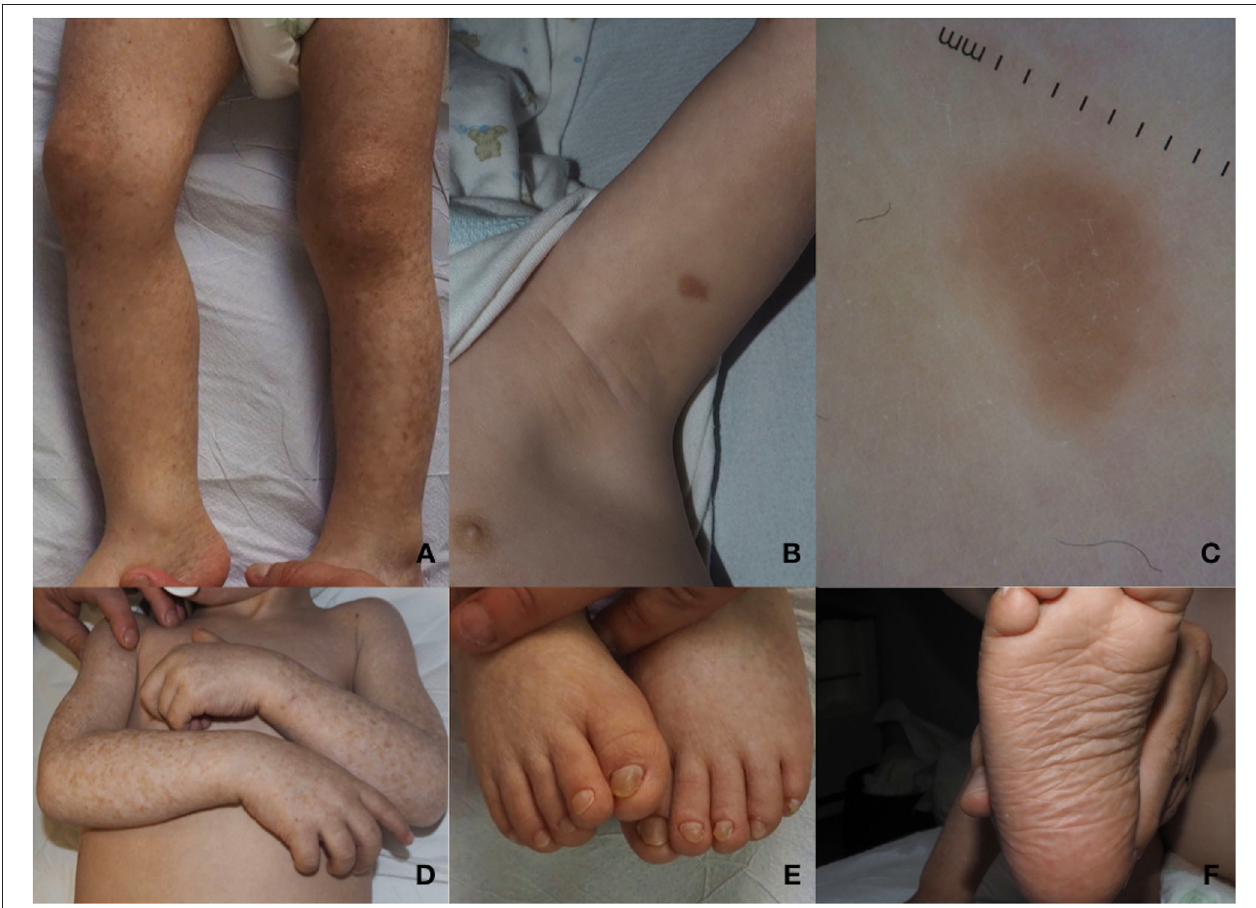
FIGURE 2 | (A) Diffuse reticulated squamous hyperpigmentation surrounding slightly hypopigmented areas of the lower limbs. (B) Brownish infiltrated plaque on the left arm. (C) On polarized light dermoscopy, a homogeneous light brown structureless area is observed. (D) Mottled hypo- and hyperpigmentation on the arms, lesions typically localized on photoexposed areas. (E) Pachyonychia of the toenails. (F) Plantar spiny